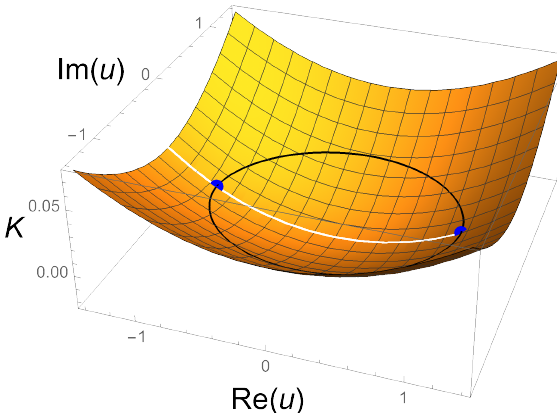
Figure 1. The Kähler potential for gauge group SU(2) in the complex u -plane (with Λ = 1 ), made using the hypergeometric function representation of the periods (see section 2.4). The black curve indicates the K = 0 contour; it is the boundary of the strong-coupling region where K < 0 . Note that the monopole and dyon points (indicated by the blue dots) lie on this K = 0 boundary. Z 2 N -symmetric point and show that it is negative, scaling with